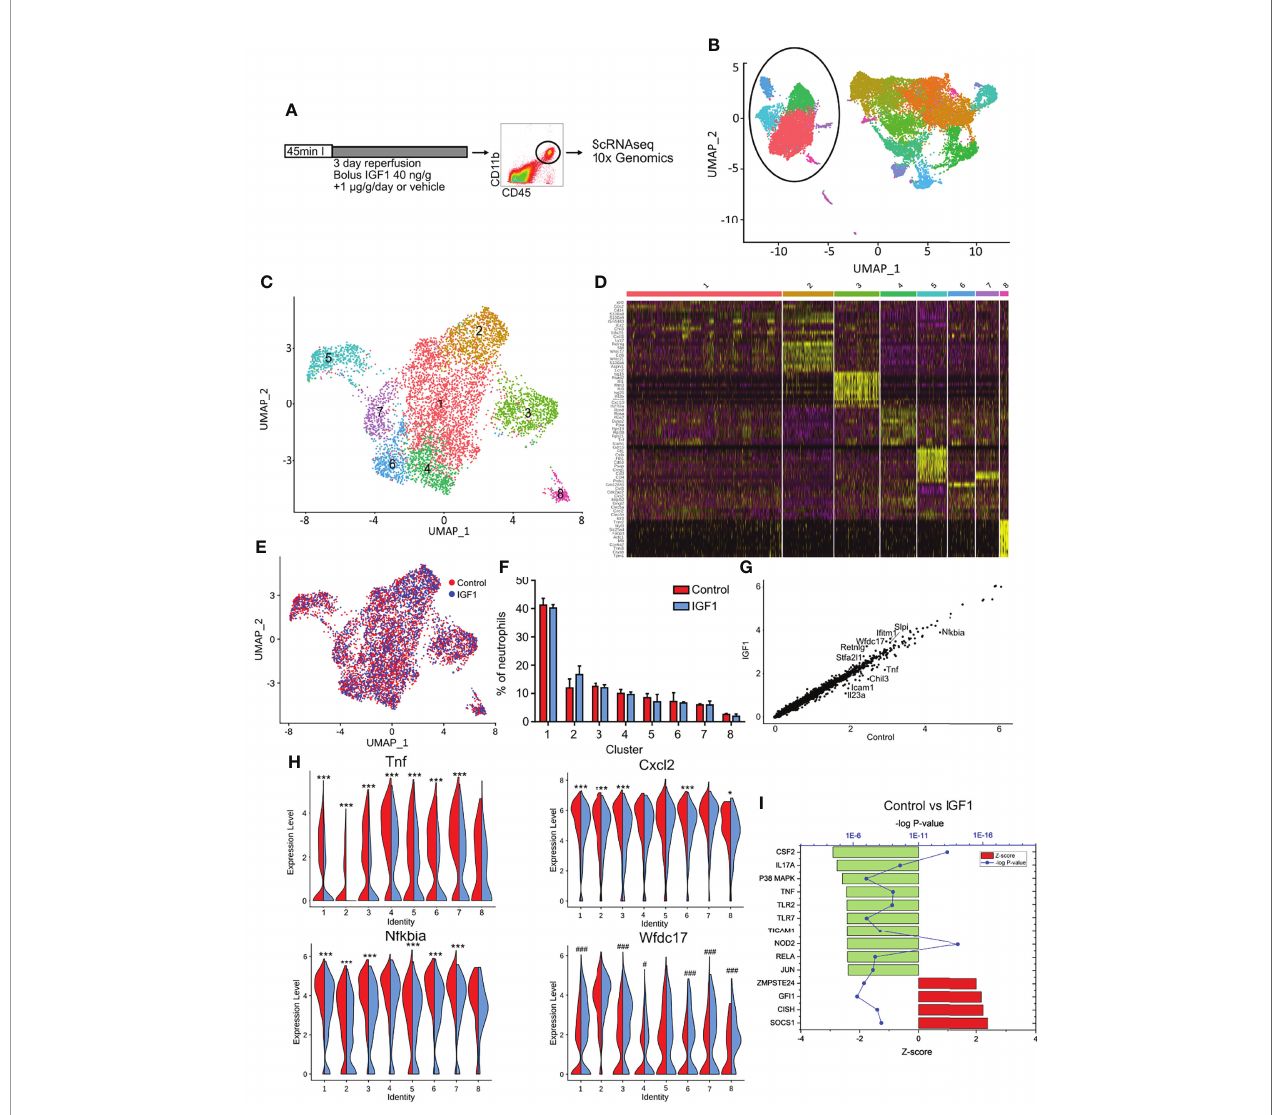
FIGURE 6 | IGF1 treatment creates an anti-in fl ammatory phenotype of neutrophils after myocardial infarction. (A) Experimental protocol. C57BL/6J mice were subjected to 45-min LAD coronary artery occlusion and 3 days of reperfusion. At the start of reperfusion mice were treated with IGF1 or vehicle for 3 days. Hearts were digested and cardiac CD45+CD11b+ cells were sorted out for single cell RNA sequencing using the 10x Genomics platform. (B) UMAP of all CD45+CD11b+ cells shows a clear difference between neutrophils and other CD11b+ cells. Neutrophils are encircled. (C) Reclustering of neutrophils with a higher resolution results in 8 different neutrophil clusters. (D) Heatmap depicting the top 10 differently expressed genes for each cluster. (E) UMAP showing control (red) and IGF1 treated (blue) neutrophils does not show a differences in the distribution of neutrophils over the clusters. (F) The amount of neutrophils per cluster as percentage of the total number of neutrophils. (G) A scatter plot of all pooled neutrophils shows differences in gene expression between control and IGF1 treated neutrophils. The top 10 differently expressed genes are shown. (H) Violin plots show a clear difference in the expression of Tnf , Nfkbia, Cxcl2 and Wfdc17 in most clusters between control (red, left) and IGF1 (blue, right) treated neutrophils. (I) Upstream regulators that are affected after IGF1 treatment with a Z-score>2.0 after pooling all neutrophils. The 12 most changed upstream regulators are shown. Upstream regulators per cluster are represented in Figure S4 . *p<0.05 higher in control, ***p< 0.001 higher in control, # p<0.05 higher in IGF1, ### p<0.001 higher in